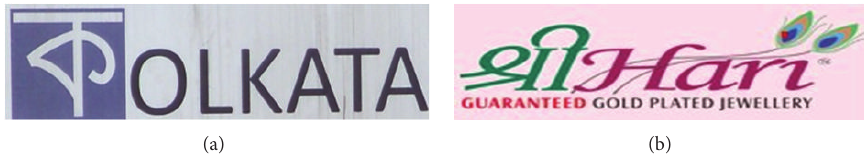
Figure 13: Words showing multiple scripts at character